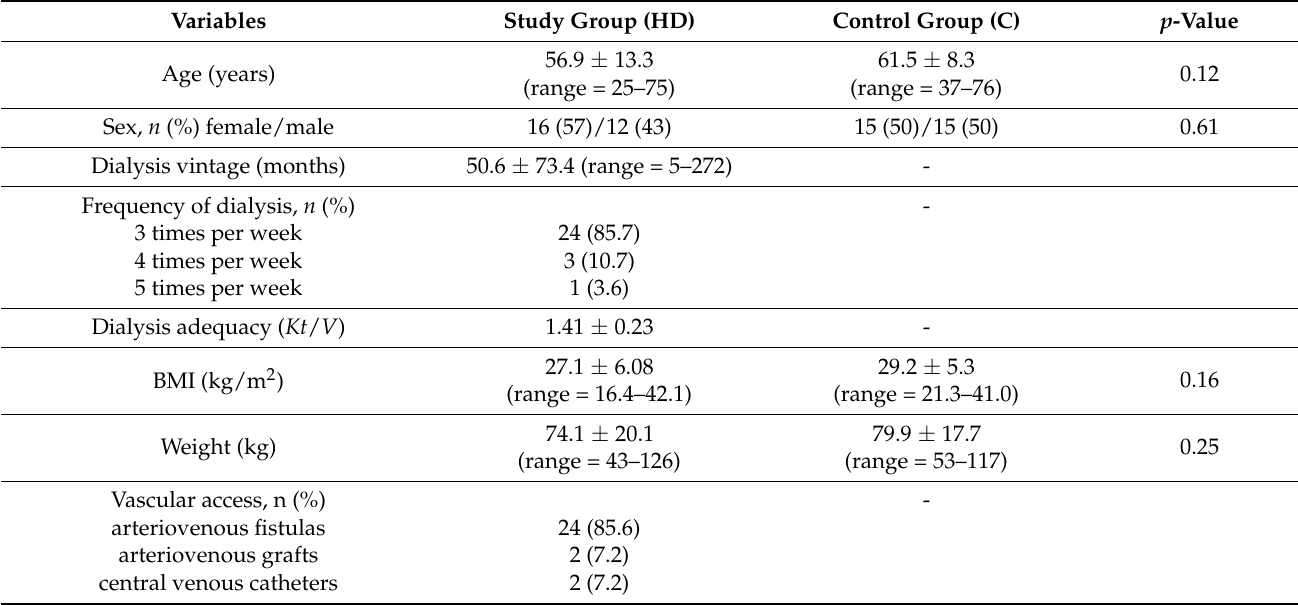
Table 1. Baseline characteristics of patients participating in the study ( n =